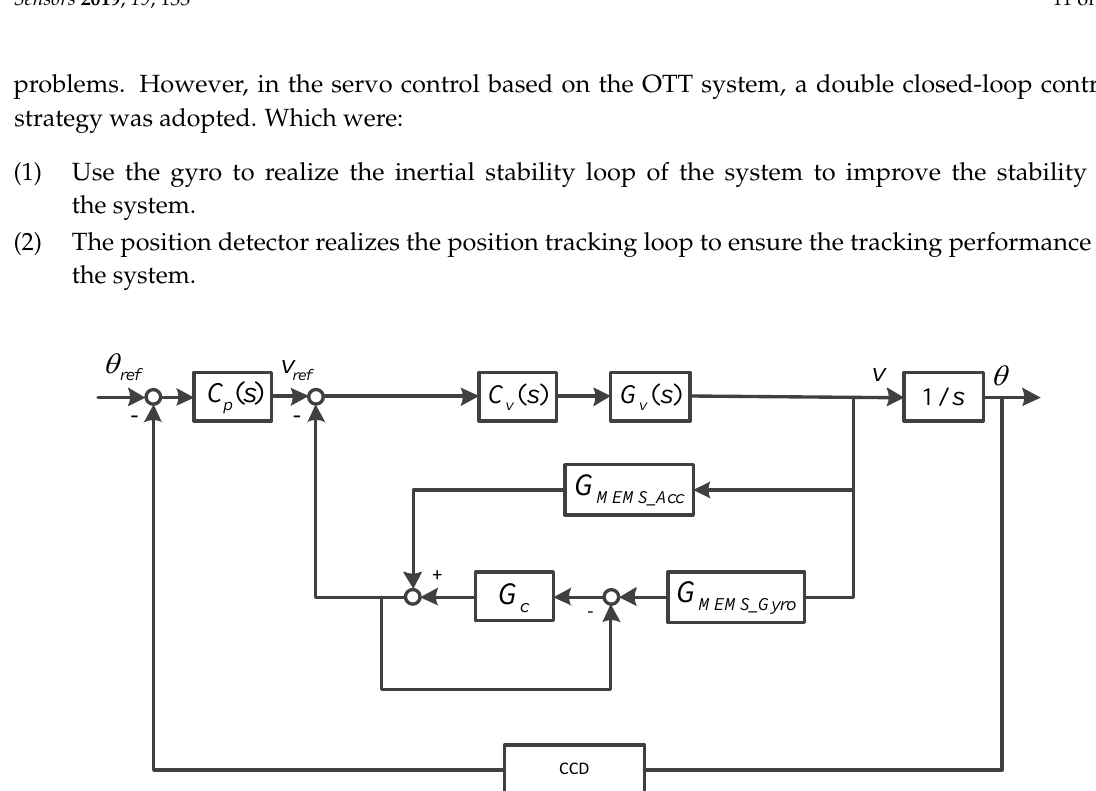
Figure 14. The control structure of OTT.